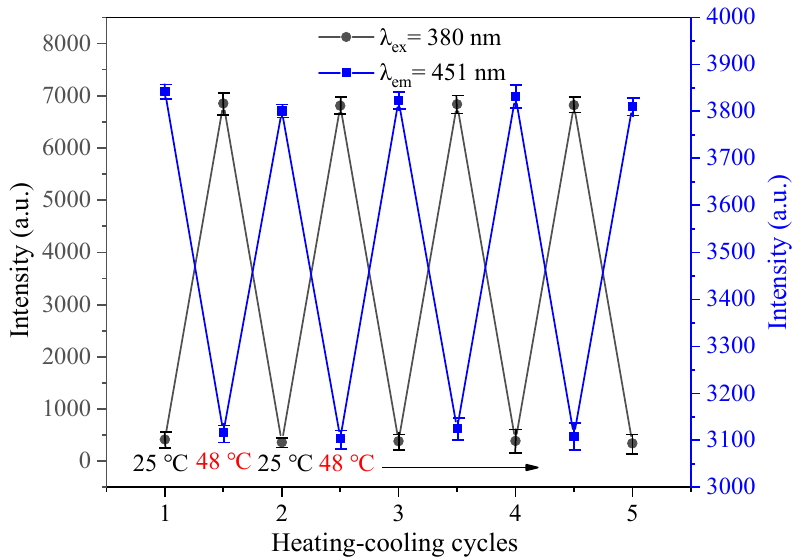
Figure 4. The scattering peak intensity ( ) at 380 nm and the emission peak intensity ( ) at 451 nm as a function of heating-cooling cycles between 25 °C and 48 °C.